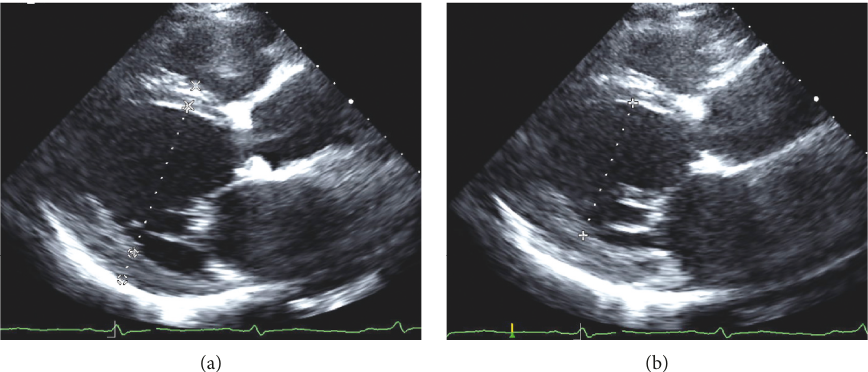
Figure 2: Transthoracic echocardiogram for cardiac size and function. (a) Parasternal long-axis view demonstrating severe dilatation (end- diastolic diameter of 64mm) with normal anterior septal and inferior lateral wall thickness (9 and 12mm, respectively). (b) Similar view demonstrating increased end-systolic dimension (57 mm) consistent with reduced ejection